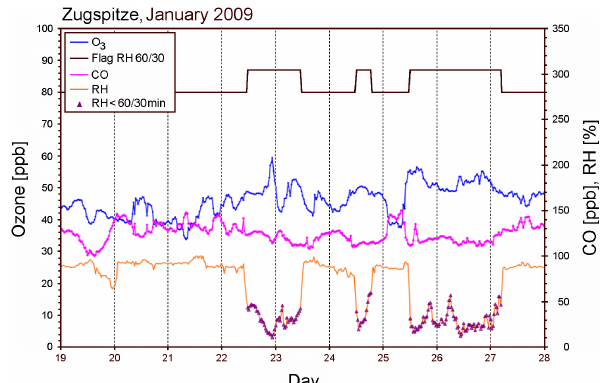
Figure 13. Zugspitze data around 22 January 2009; the maximum of intrusion layer L4 is visible during the final hours of 22 January. Fig. 13. Zugspitze data around January 22, 2009; the maximum of intrusion layer L4 is visible CO drops by only 10ppb during that during the final hours of January 22. CO drops by only 10 ppb during that period.